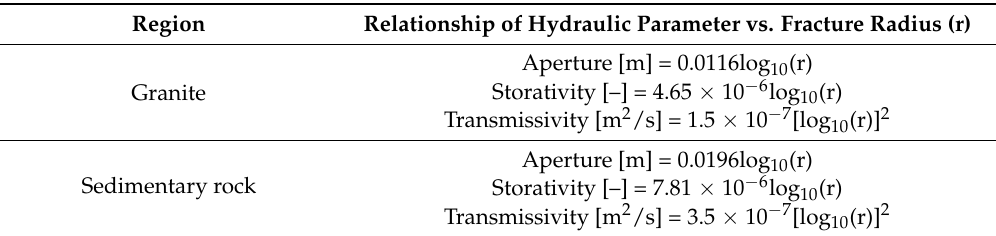
Table 2. Hydraulic parameters for DFN upscaling in granite and sedimentary rock regions.